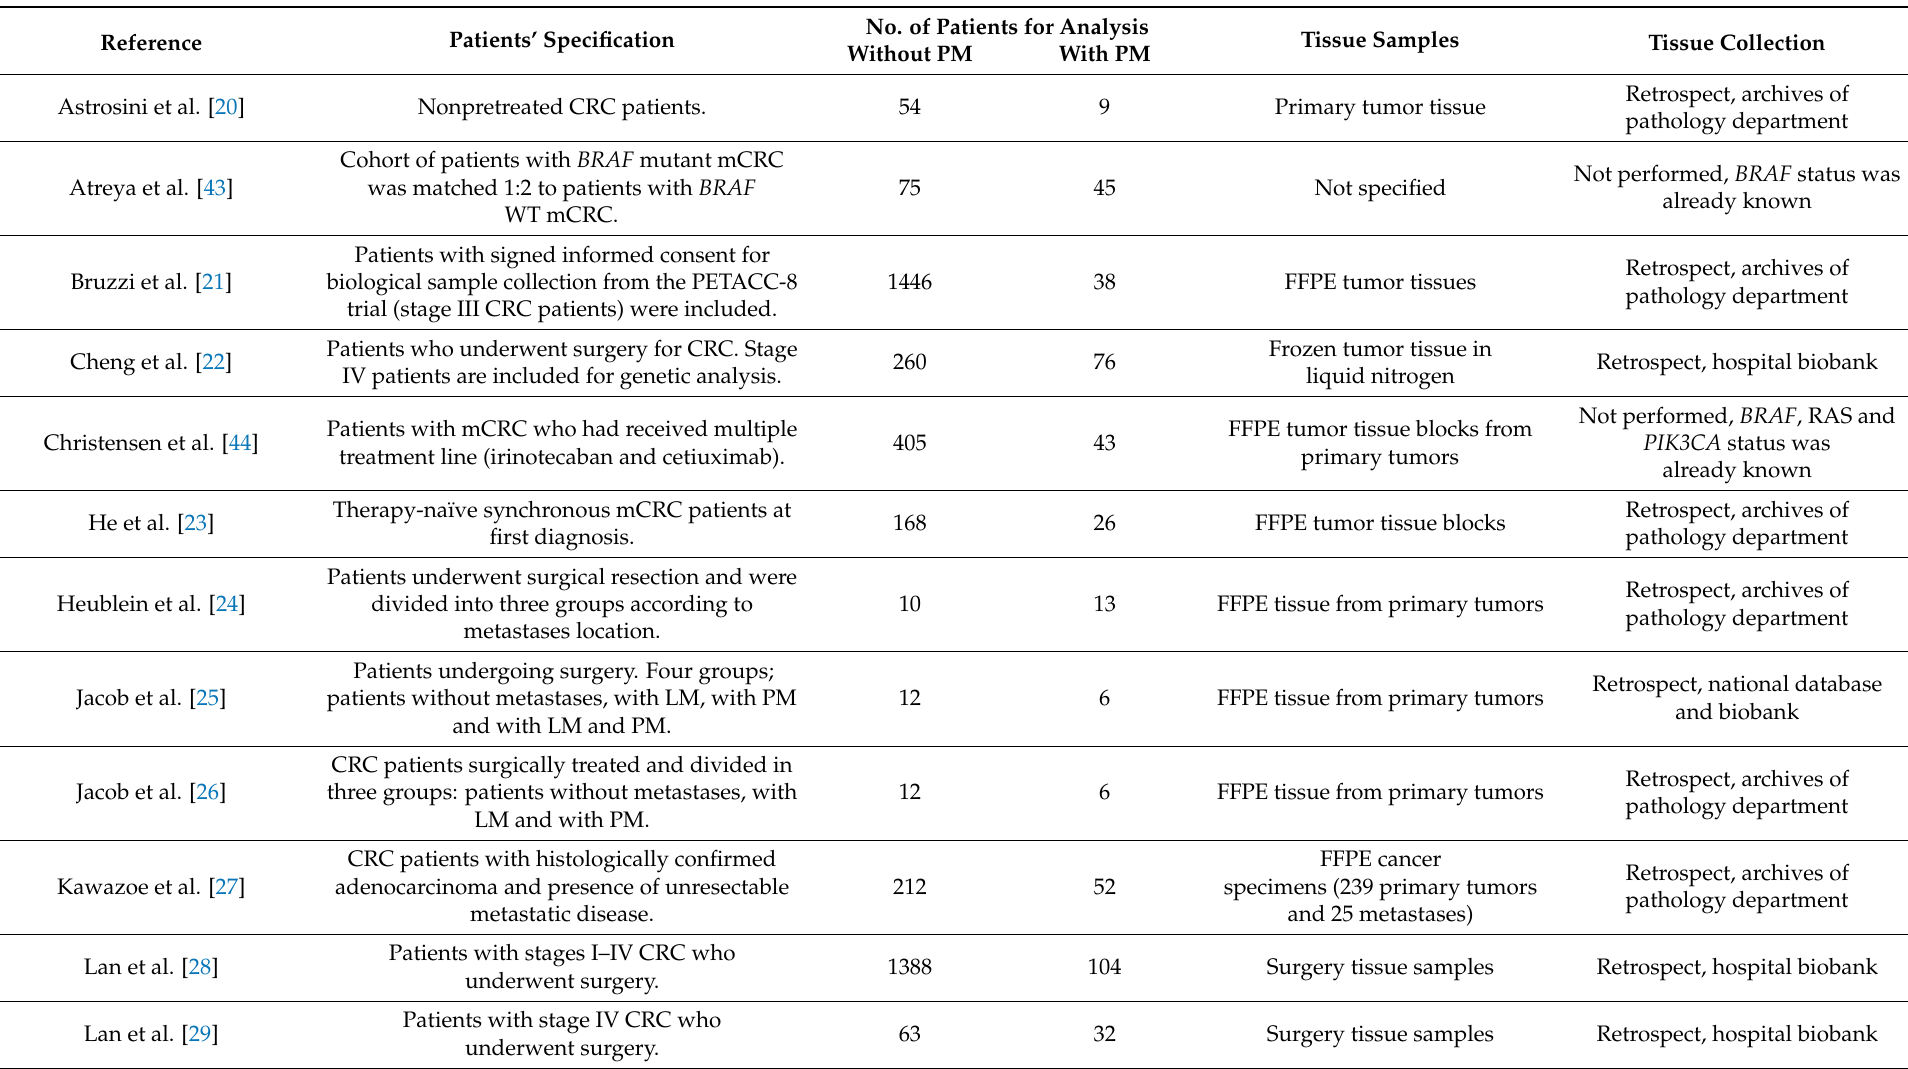
Table 2. Characteristics of patients and tissue samples in included